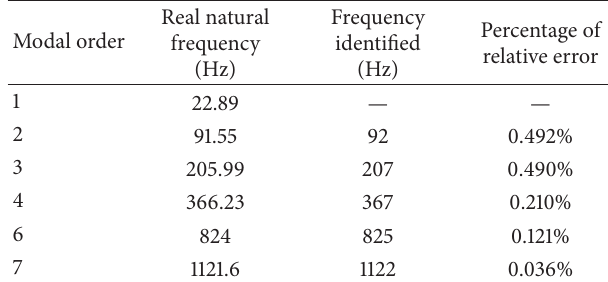
Table 15: Error of natural frequencies identified by maximization negentropy with quasi-Newton iteration method with measurement noise.